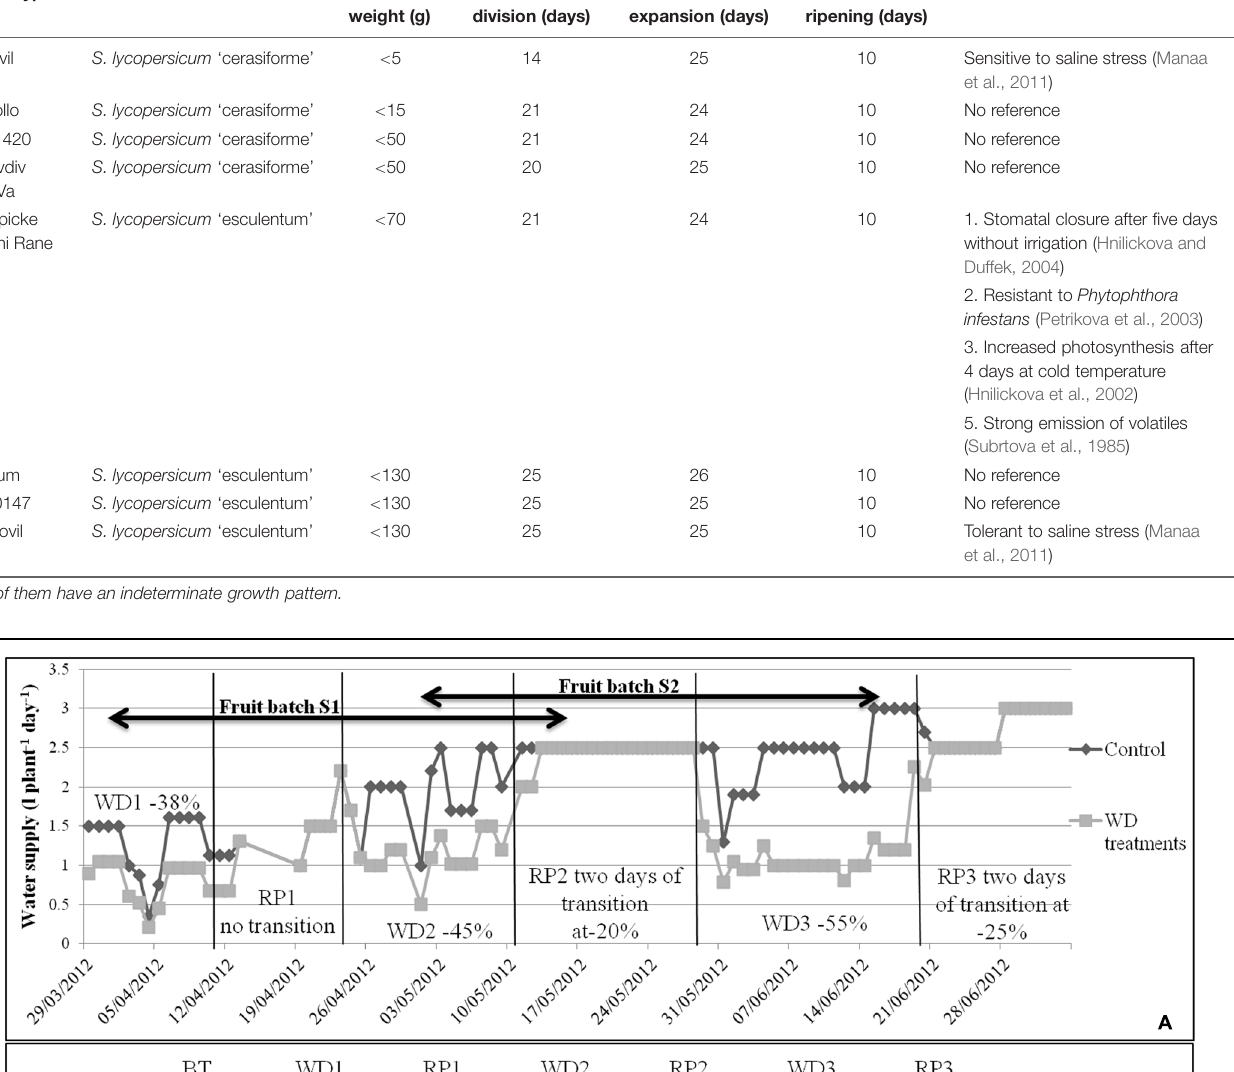
TABLE 1 | Some characteristics of the eight parents of the MAGIC TOM population selected for their high degree of allelic variability (Ranc, 2010). Genotype